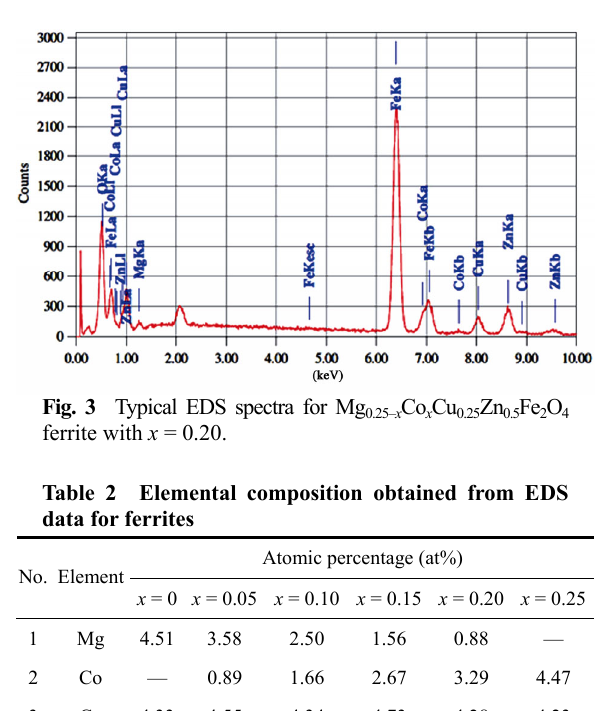
log  ) as a function of tem- DC